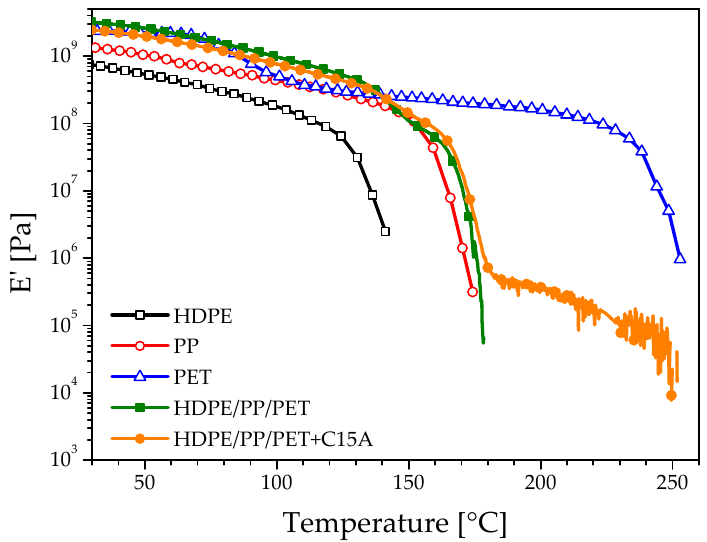
Figure 3. Storage modulus for the neat polymers and the blends as evaluated by DMA.